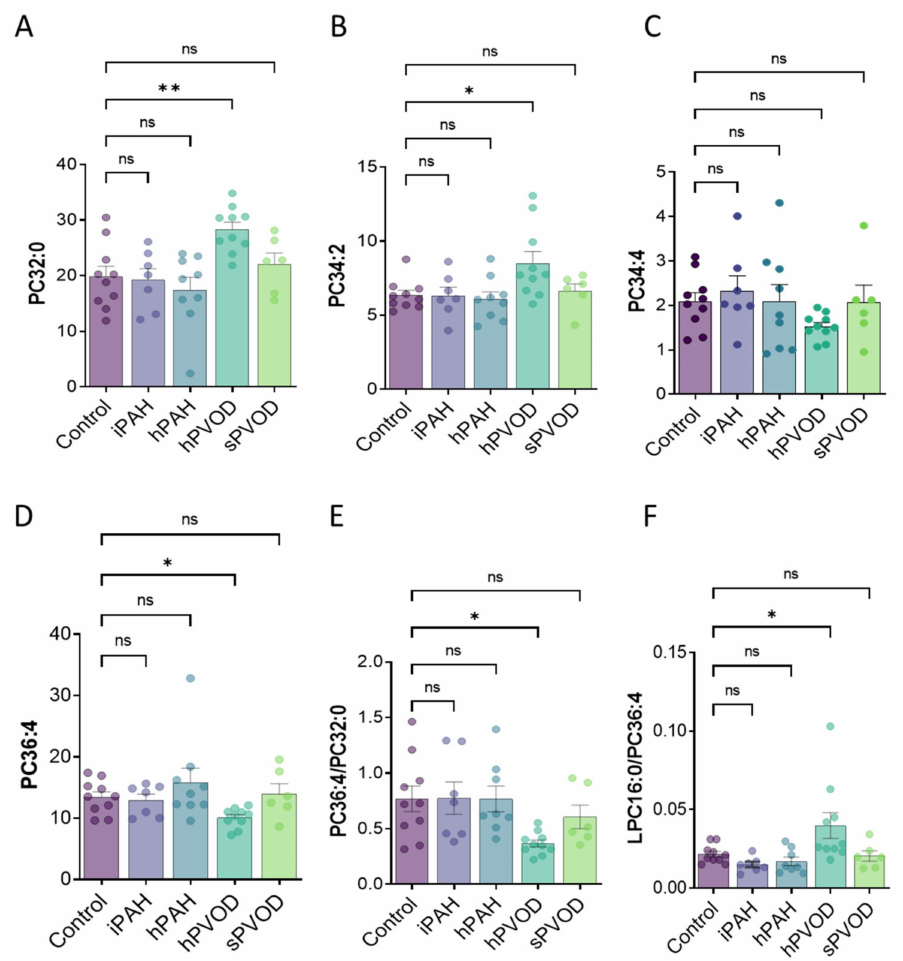
Figure 2. hPVOD lung tissues are characterized by lipointoxication. ( A ) PC32:0; ( B ) PC34:2; ( C ) PC34:4; ( D ) PC34:1. ( E ) PC36:4/PC32:0 ratio in lungs from control, iPAH, hPAH, hPVOD, and sPVOD patients. ( F ) LPC16:0/PC36:4 ratio in lungs from control, iPAH, hPAH, hPVOD, and sPVOD patients. ns: non-significant, * p < 0.05, ** p <